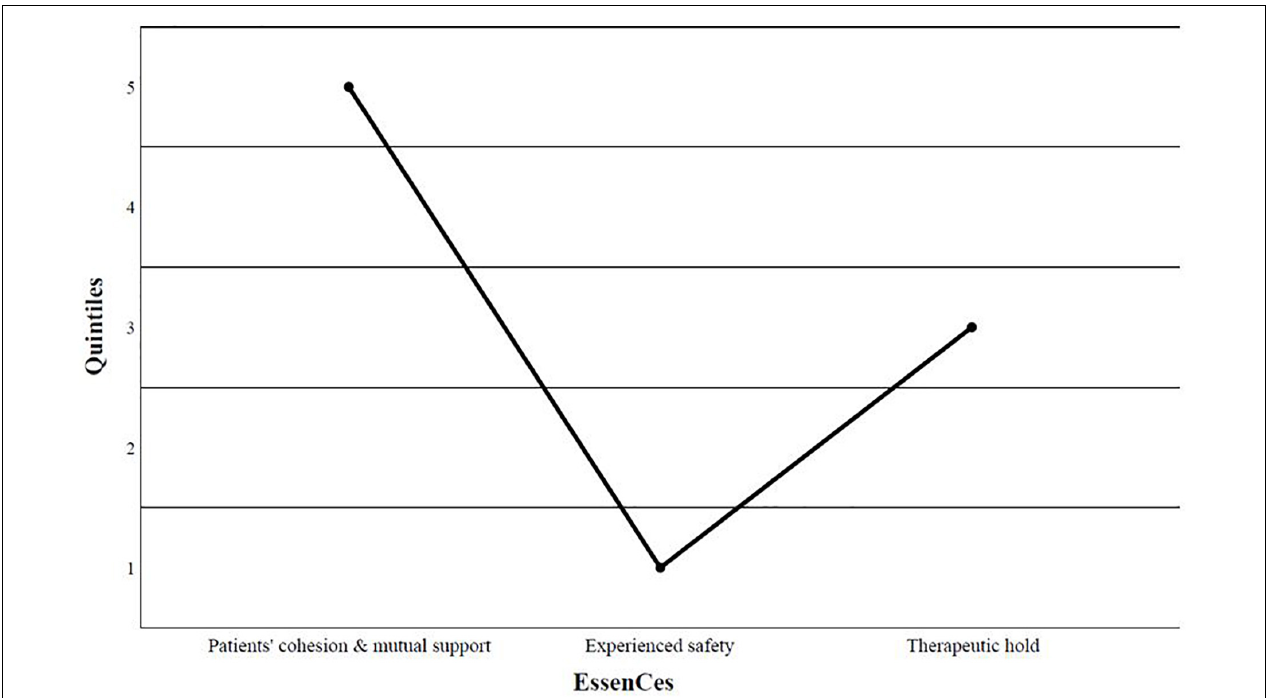
FIGURE 3 | Classification of the ward climate according to the qiiintiles of the forensic reference sample of Schalast and Tonkin (2016), ( N = 236). Q1 = clearly below average, Q2 = somewhat below average, Q3 = average, Q4 = somewhat above average, Q5 = clearly above